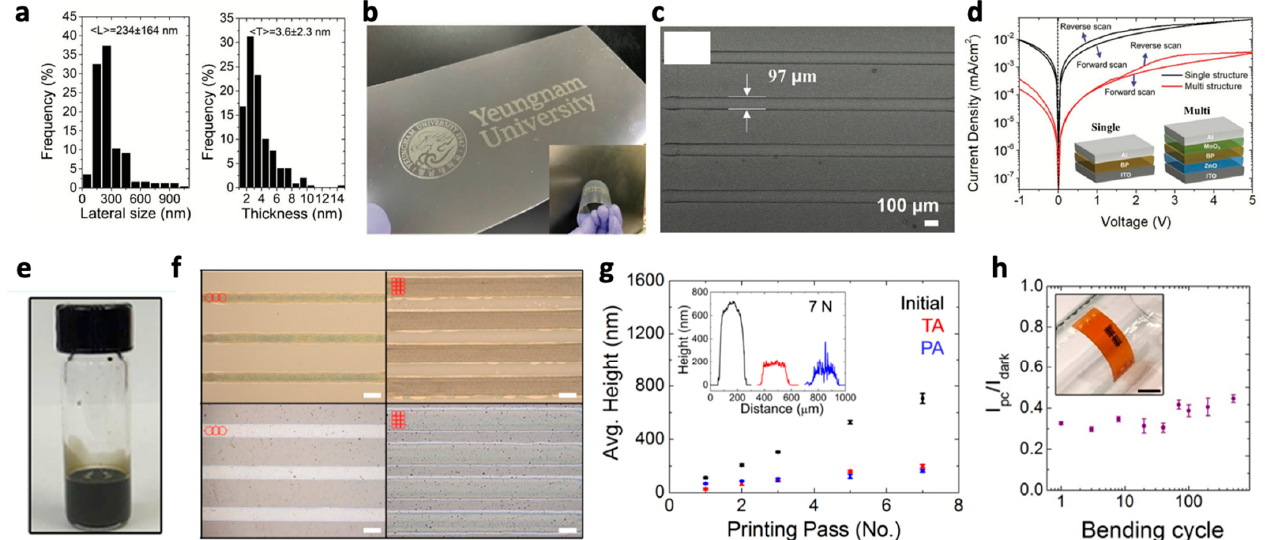
Figure 5. ( a ) Statistical dimensional analysis of exfoliated BP NSs; characterizations of the printed BP films upon printing repetition (N): ( b ) patterned BP film on PET substrate (100 mm × 40 mm); ( c ) SEM image of printing line at droplet spacing of 25 μ m and 5 N; ( d ) diode characteristics of the single- and multi-structured BP film. Reprinted with permission from Ref. [22]. Copyright 2021 John Wiley and Sons. ( e ) Photograph of the MoS 2 /EC ink; ( f ) inkjet-printed MoS 2 /EC lines on glass (top) and polyimide (bottom). The width of the printed lines can be tuned with the number of rows of droplets per line, as indicated by the red circles. The scale bar is 100 µ m; ( g ) average height measured by profilometry from the as-printed (initial), thermally annealed (TA), and photonically annealed (PA) MoS 2 /EC lines. Inset: height profiles from the initial (black), TA (red, 177.65 ± 14.52 nm), and PA (blue, 124.68 ± 49.63 nm) lines after 7 printing passes, illustrating larger standard deviation in thickness and morphological roughness after PA; ( h ) bending test over 500 cycles showing invariant sensitivity. Inset: photograph of the flexible MoS 2 -Gr device. The scale bar is 3 mm. Reprinted with permission from Ref. [49]. Copyright 2019 American Chemical